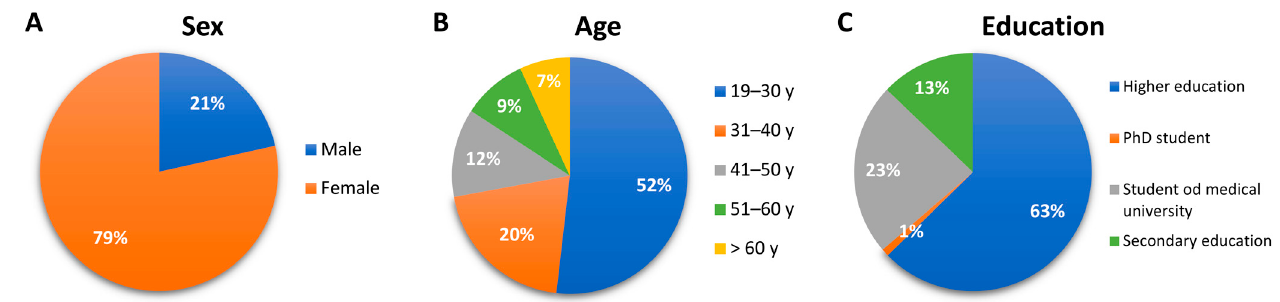
Figure 1. The characteristics of the study group: ( A ) sex, ( B ) age, ( C )